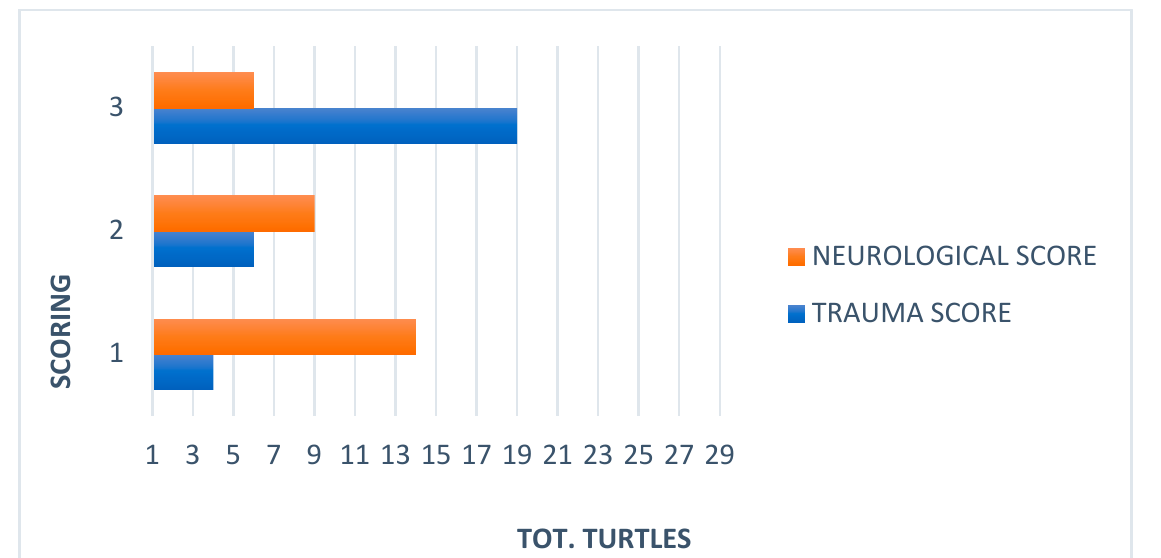
Figure 3 . Comparison between trauma and neurological scores in 29 Caretta caretta .